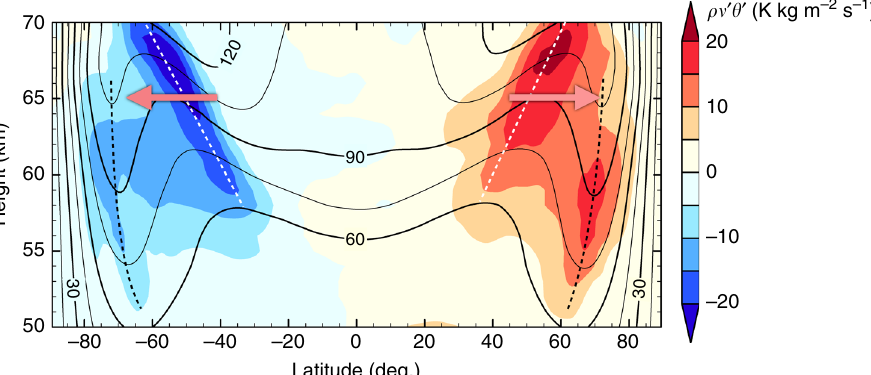
Fig. 8 Zonally and temporally averaged distributions of zonal winds (contour) and north-south eddy heat fl uxes (colour) in ZS0. White dashed lines indicate locations of large poleward heat fl uxes suggesting the emergence of baroclinic instability in mid-latitudes; black dashed lines indicate those in high- latitudes and the axes of high-latitude jets. Red arrows show approximate latitudes of large poleward angular momentum fl uxes by eddies at the altitude of 65 km, which is shown in Fig. 7b. The time averaging period is the same as Fig. 5 and contour interval is 15 m s −